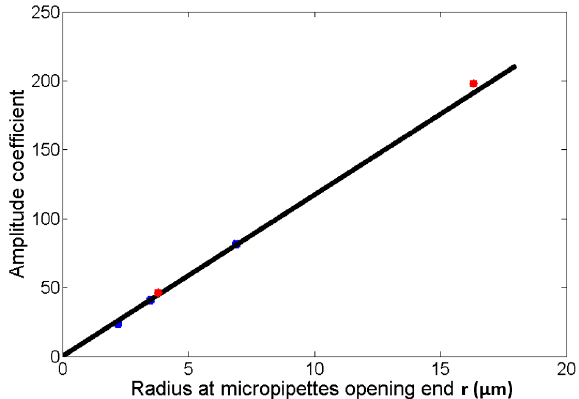
Figure 10. The amplitude coefficient versus radius at the micropipette opening r . The blue points are the amplitude coefficient in Equations (6), (8), and (10). The black line is the fitting result. The red points are the amplitude coefficient versus r being 3.8 μ m and 16.3 μ m, respectively.